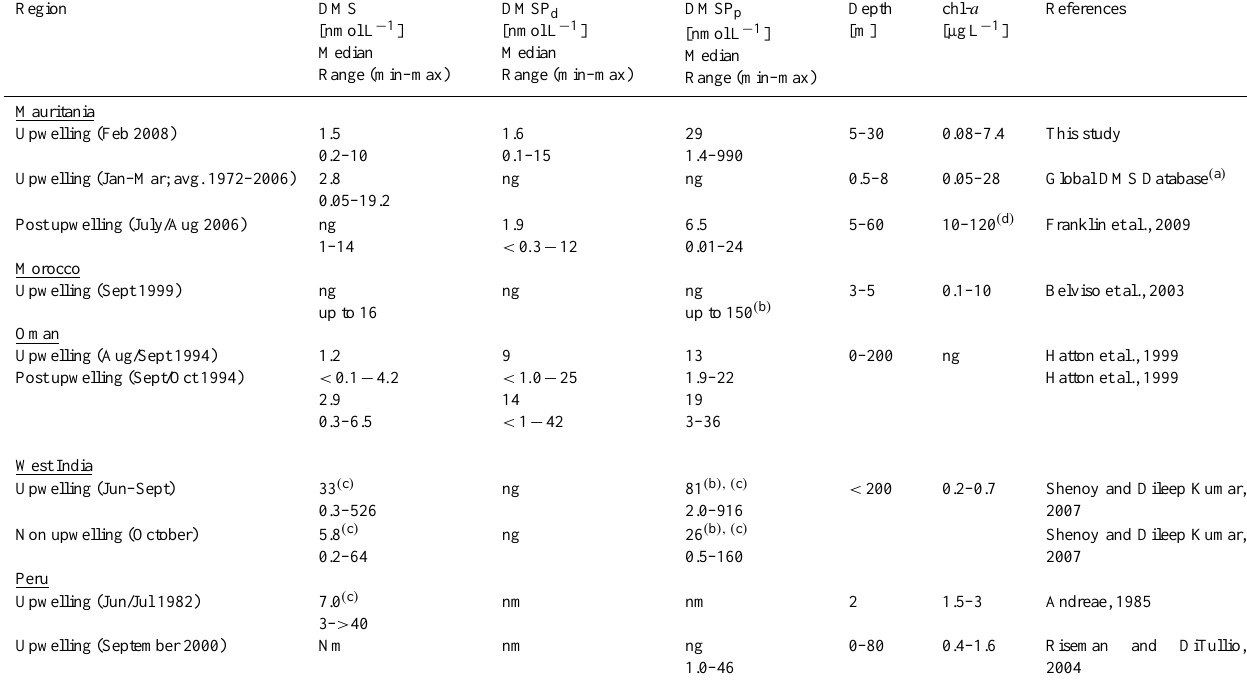
Table 1. DMS and DMSP concentrations in coastal upwelling regions.